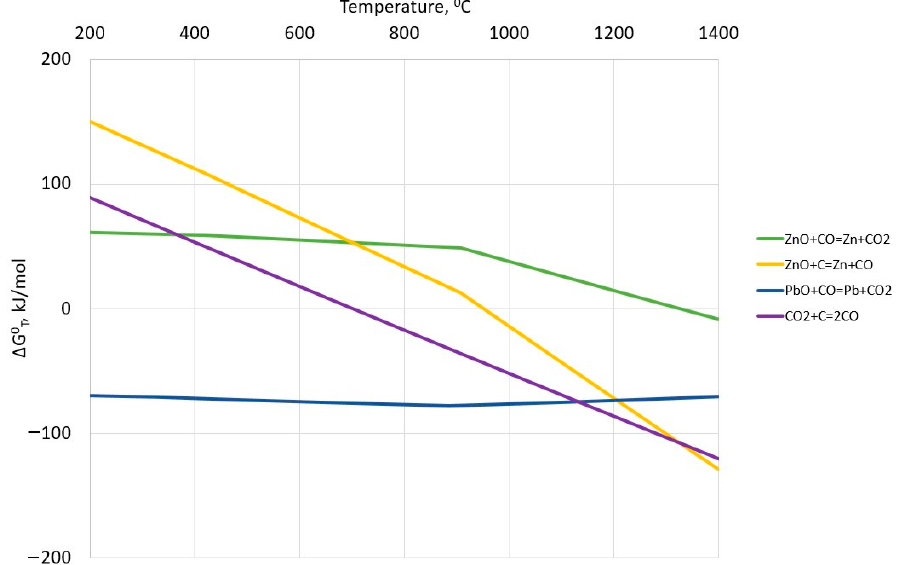
Figure 2. Free Gibbs energy in the temperature dependence for the main reaction in ISP.